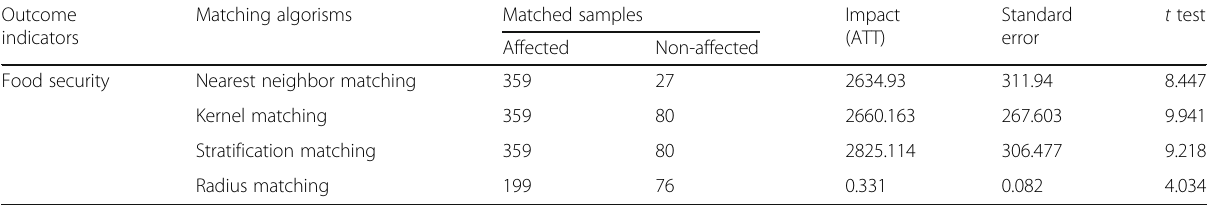
Table 4 Impact of adaptation Outcome